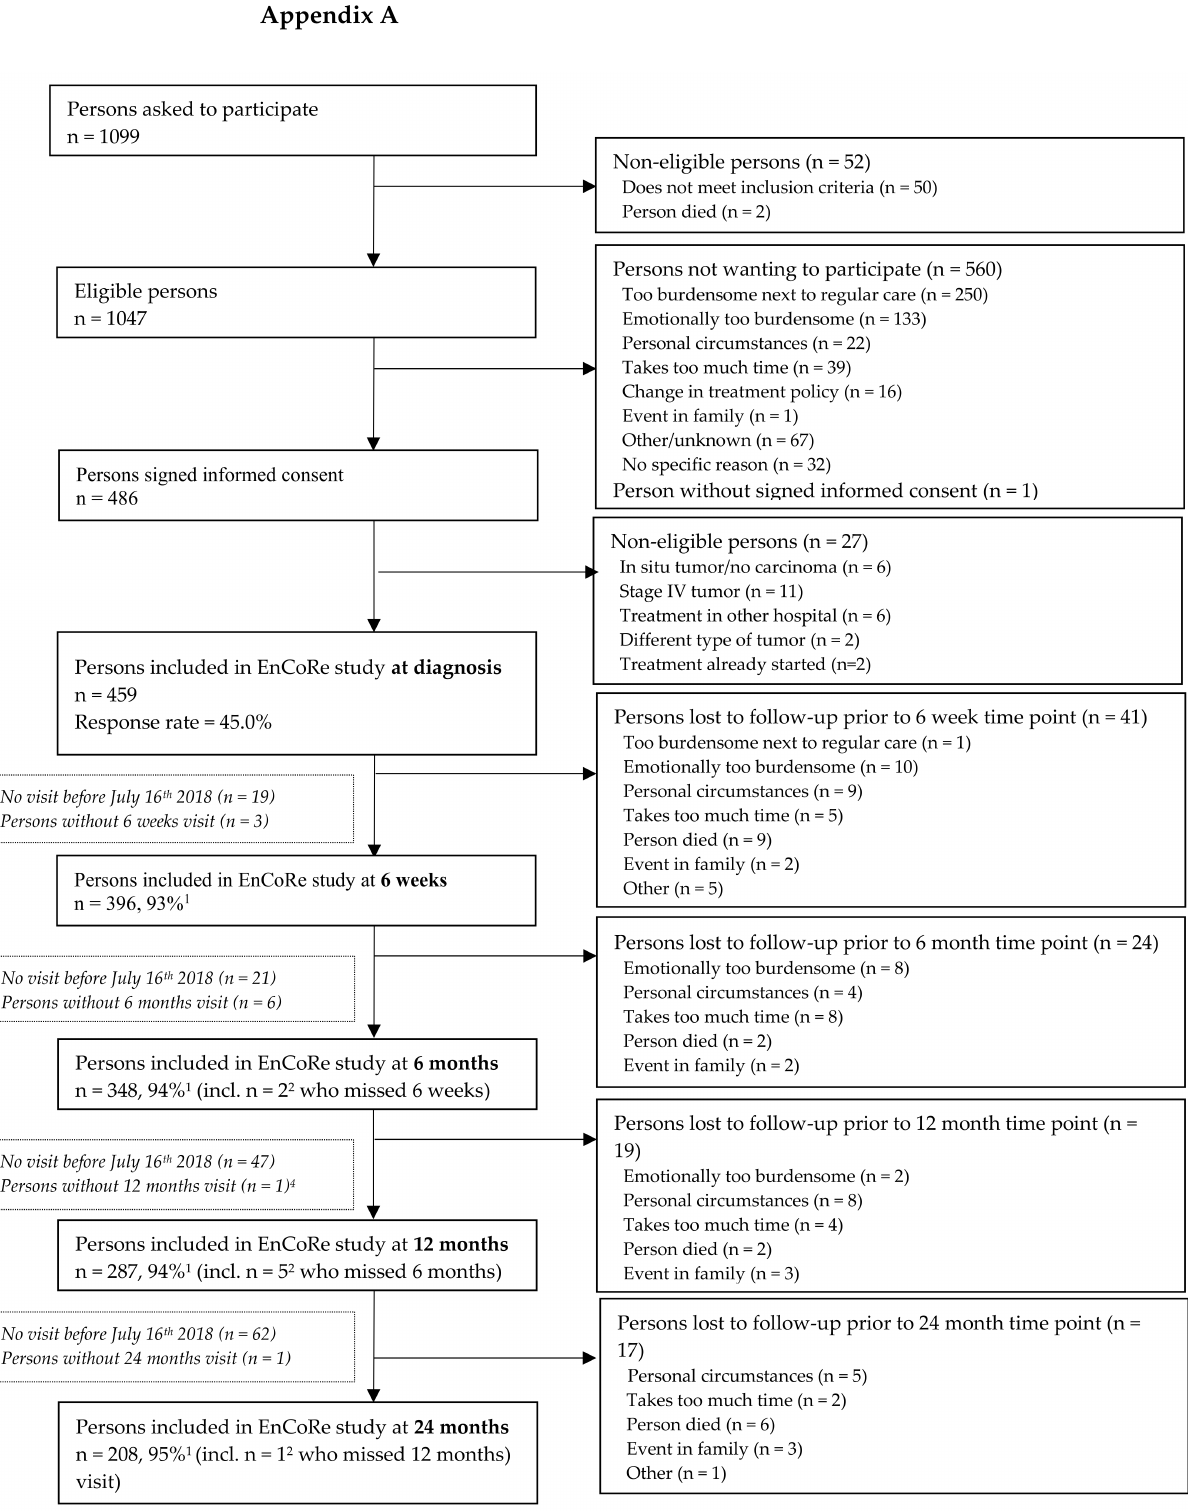
Figure A1. Flow diagram of inclusion of individuals within the EnCoRe study. Data of home visits performed before 16 July 2018 were included in this paper. 1 Response rate post-treatment = (persons included)/(persons included + persons lost to follow − persons died), 2 Of the three persons without 6 weeks follow-up visits, one person did not have a 6 months follow-up visit before 16 July 2018. Of the six persons without 6 months follow-up visits, one person did not have a 12 months follow-up visit before 16 July